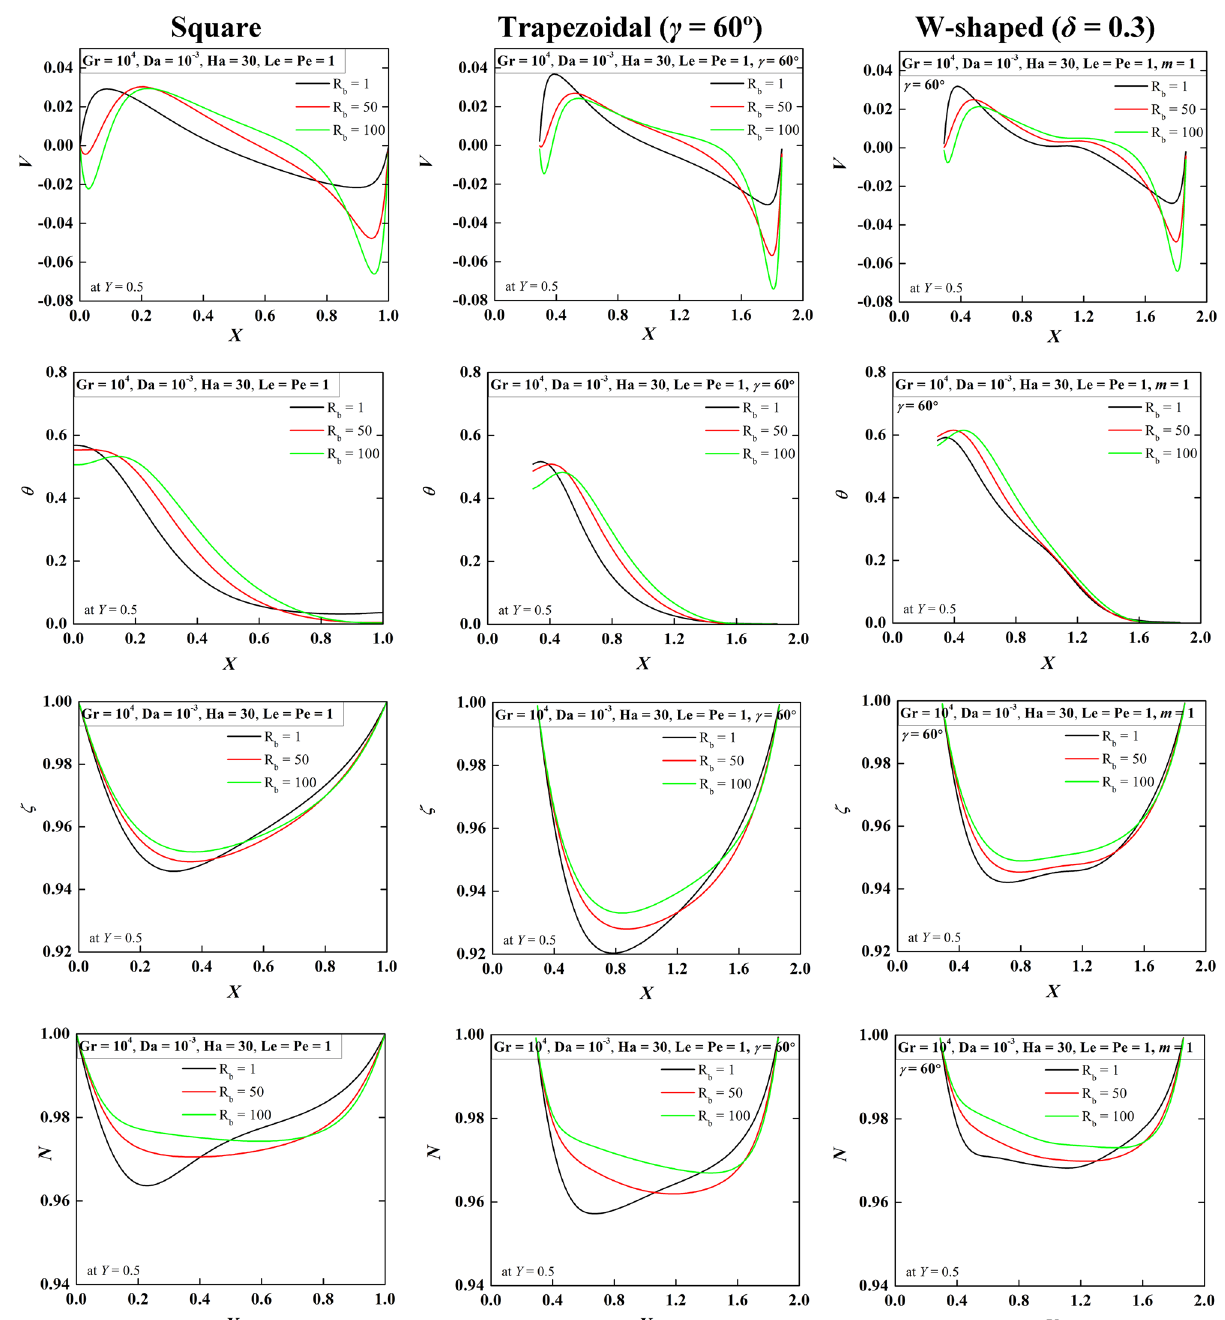
Figure 6. Distribution of local velocity (first-row), temperature (second-row), oxygen (third-row), and microorganisms (forth-row) for varying R b = 1, 50, 100 at Le = Pe = 1, Gr = 10 4 , Da = 10 –3 , Ha = 30 for square (first column), trapezoidal (second column) and W-shaped (third column)